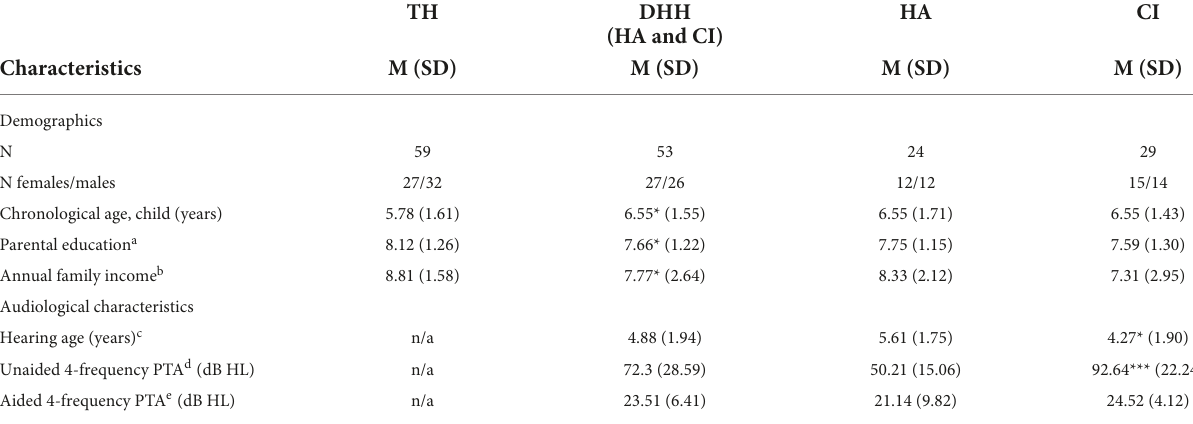
TABLE 1 T1 participant demographics and audiological